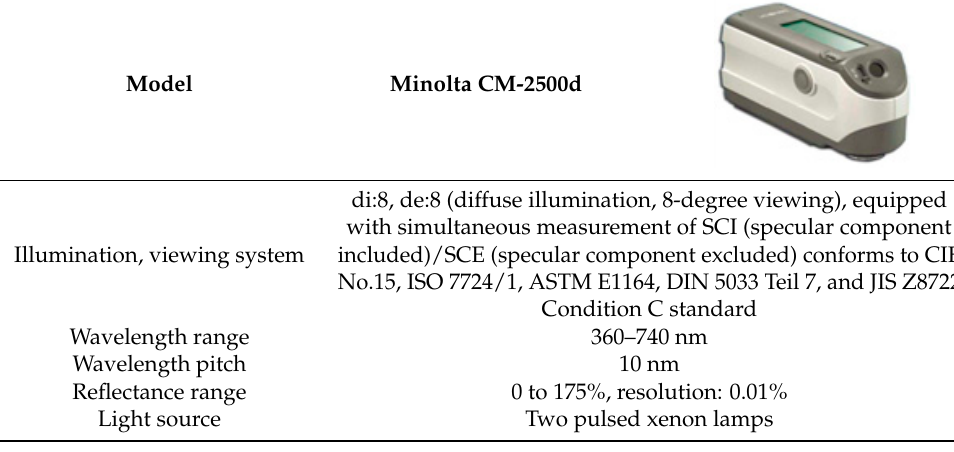
Table 4. List of public health facilities for environmental data